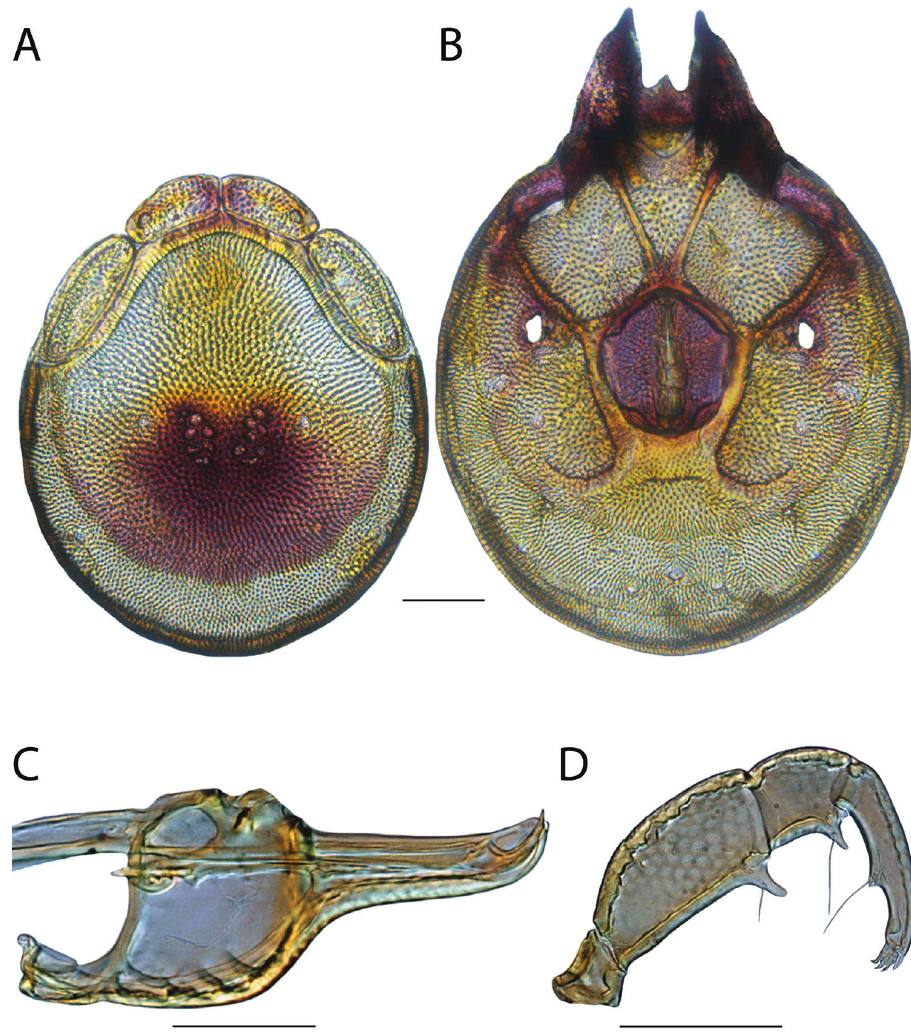
Figure 206. Torrenticola racupalpa sp. n. female: A dorsal plates B venter (legs removed) C subcapitulum D pedipalp (setae not accurately depicted). Scale = 100